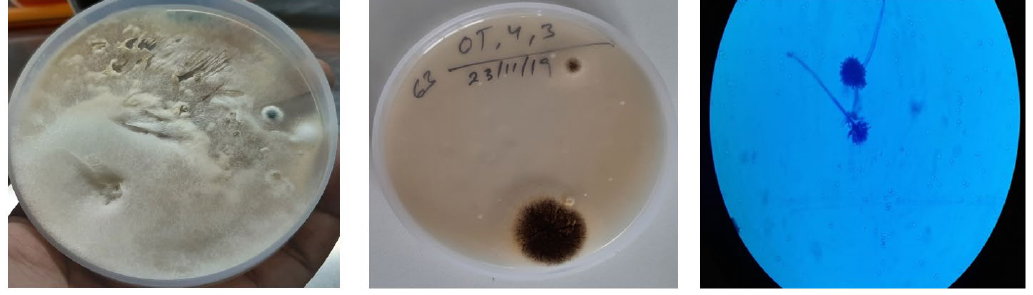
Fig. 1. Culture and stained image representing the growth of Aspergillus Niger . A. Initial white colonies, B. While colonies changed to black after few days producing conidial spores. The edges of colonies appear pale yellow producing radial fissures. C. Staining image representing Aspergillus Niger .